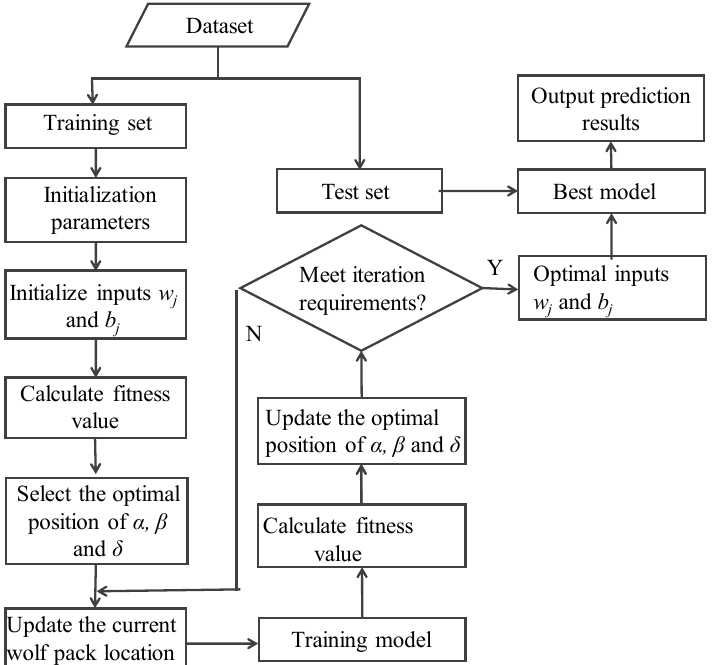
Figure 3. The schematic diagram of the GWO-ELM model structure.